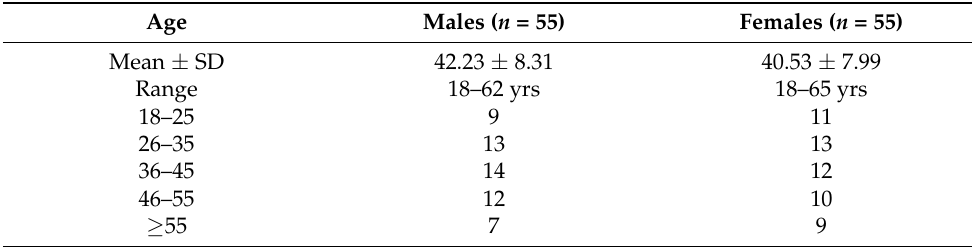
Table 1. Demographic characteristics of study